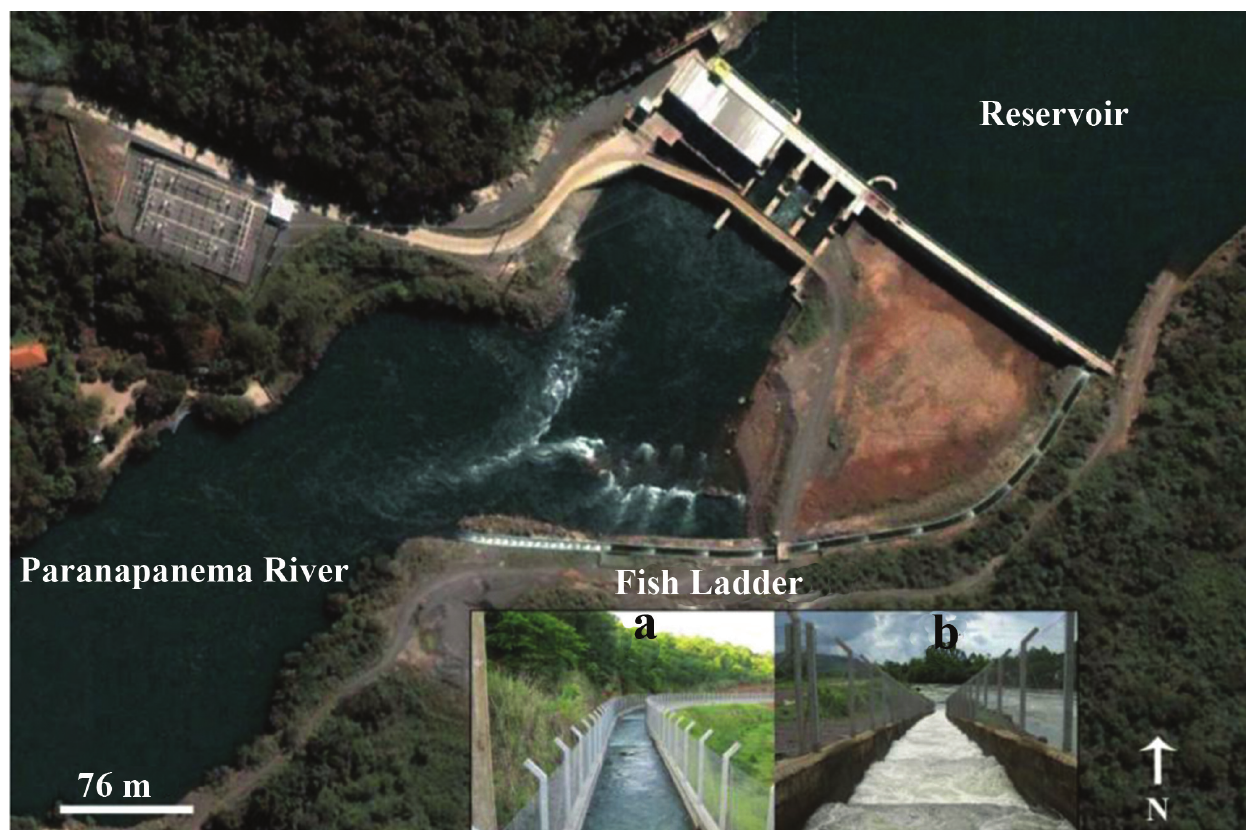
Fig. 2 . The fish ladder of Ourinhos Dam. a ) the middle stretch and b ) the ladder’s flow into the